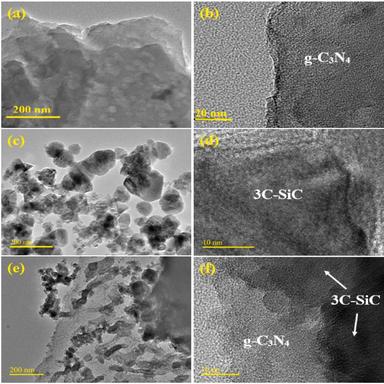
TEM and HR-TEM images of pure g-C3N4 (a–b), pure 3C–SiC (c–d) and 10%-3C–SiC@g-C3N4 nanocomposite (e–f).